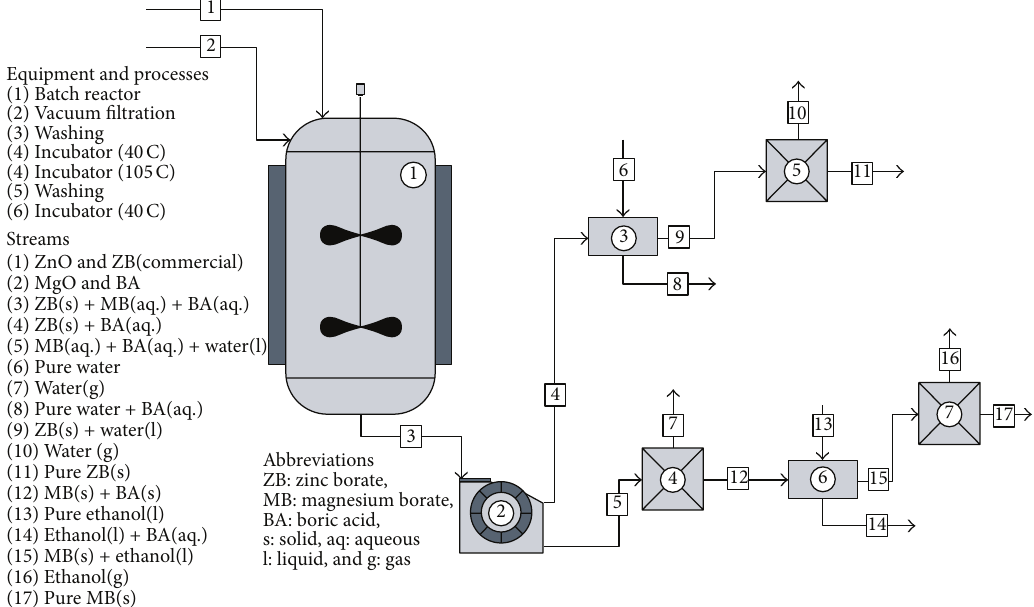
Figure 1: Reaction scheme of magnesium and zinc